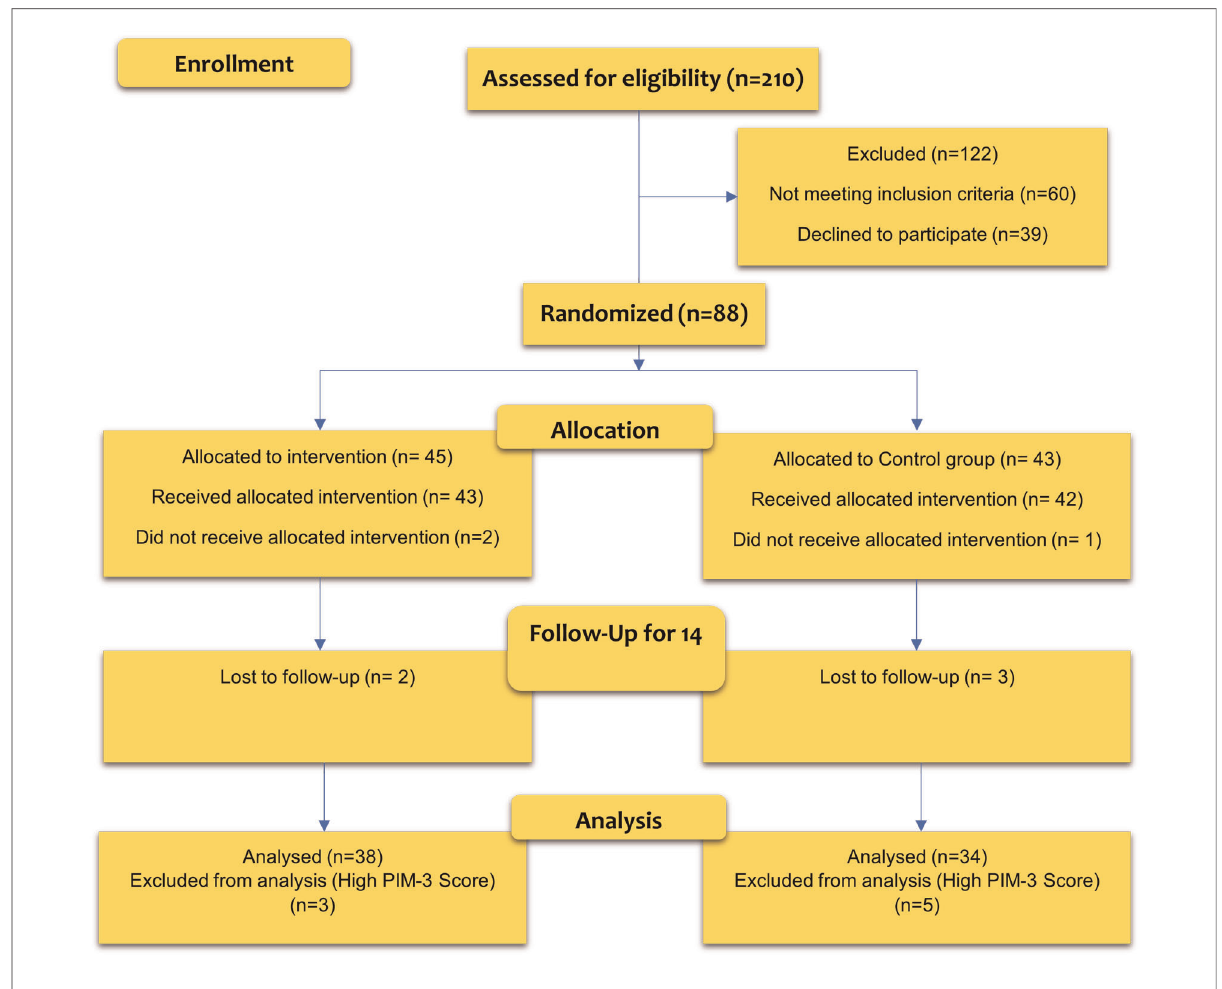
FIGURE 1 CONSORT diagram of the